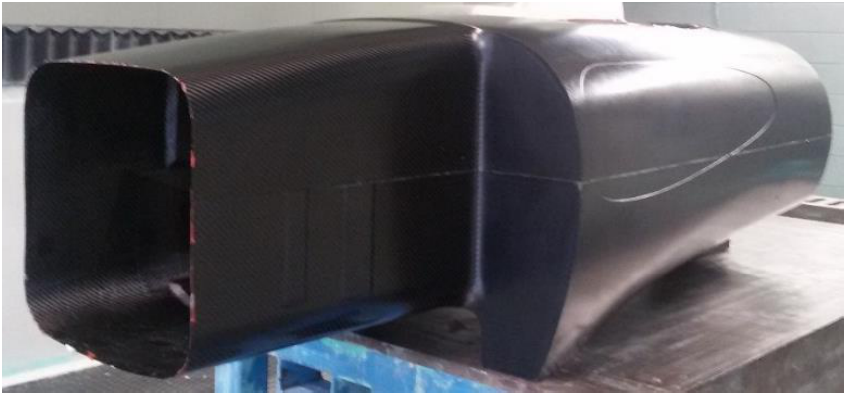
Figure 14. Final central part . Figure 15 . Full vehicle body assembled .